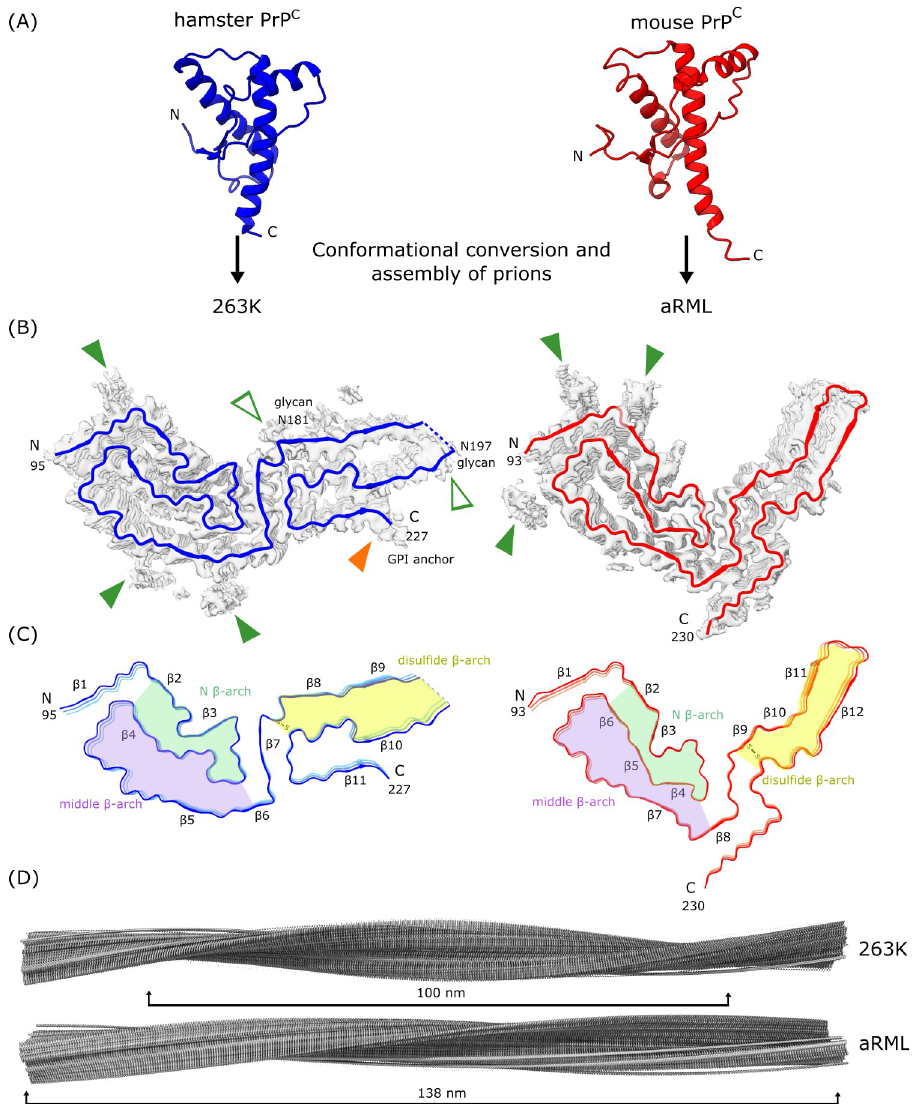
Fig 1. Two prion strains are amyloid fibrils with distinct templating surfaces on the ends where incoming monomers are refolded. AU : AbbreviationlisthavebeencompiledforthoseusedinFigs 1 and 2 : Pleaseverifythatallentriesarecorrect : (A) PrP C molecules (disordered N-terminal residues not shown) undergo conversion and assembly into the prion forms shown here for hamster 263K (blue, PDB: 7LNA, [6,7]) and mouse aRML (red, PDB: 7TD6, [8,9]) prions. PDB accession codes 1B10 and 1XYZ were used for hamster and mouse PrP C , respectively. (B) Polypeptide backbones of the fibril cross-sections (colored) as they fit within the cryo-EM density maps (gray). Open arrowheads: densities outside the polypeptide backbone that coincide with attachment sites of glycans (green) or glycolipid anchors (orange). Closed green arrowheads: densities of unknown origin outside the amyloid cores, often adjacent to cationic residues. (C) Similar shared β -arch motifs/topologies distinguished by color. Variations within these topologies and other features, including distinct orientations of the C-terminal tails, distinguish these strains. (D) Extended lateral views of fibril density maps, with brackets indicating the relative cross-over distances. cryo-EM, cryogenic electron microscopy; PrP, prion